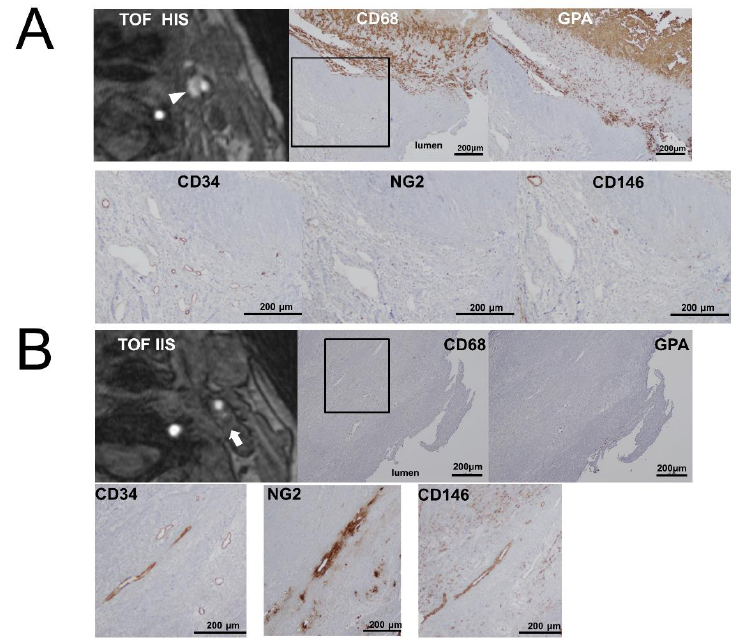
Figure 3. Representative cases of the TOF-HIS group ( A ) and the TOF-IIS group ( B ). Carotid plaques with high intensity (arrowhead) and iso intensity (arrow) signals on TOF-MRA. The photomicrographs of immunohistochemistry show many glycophorin A and CD68-positive cells in the TOF-HIS group. In both groups, CD34-positive neovessels are equally distributed. NG2 and CD146-positive neovessels are densely distributed in the TOF-IIS group. Square outlines indicate plaque shoulder